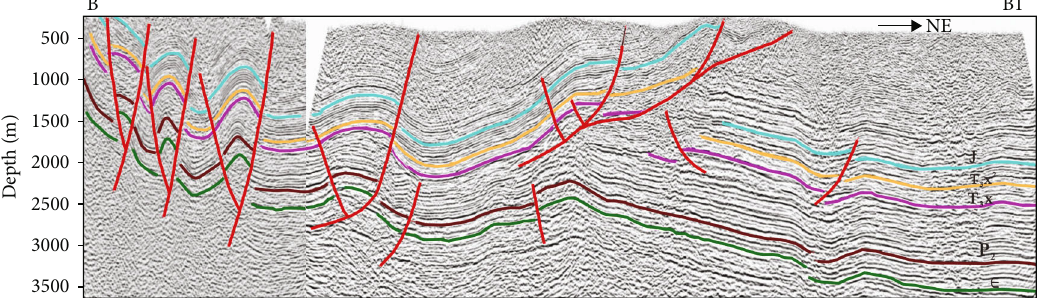
Figure 3: Seismic pro fi le of the Daxingchang tectonic system in southwestern Sichuan